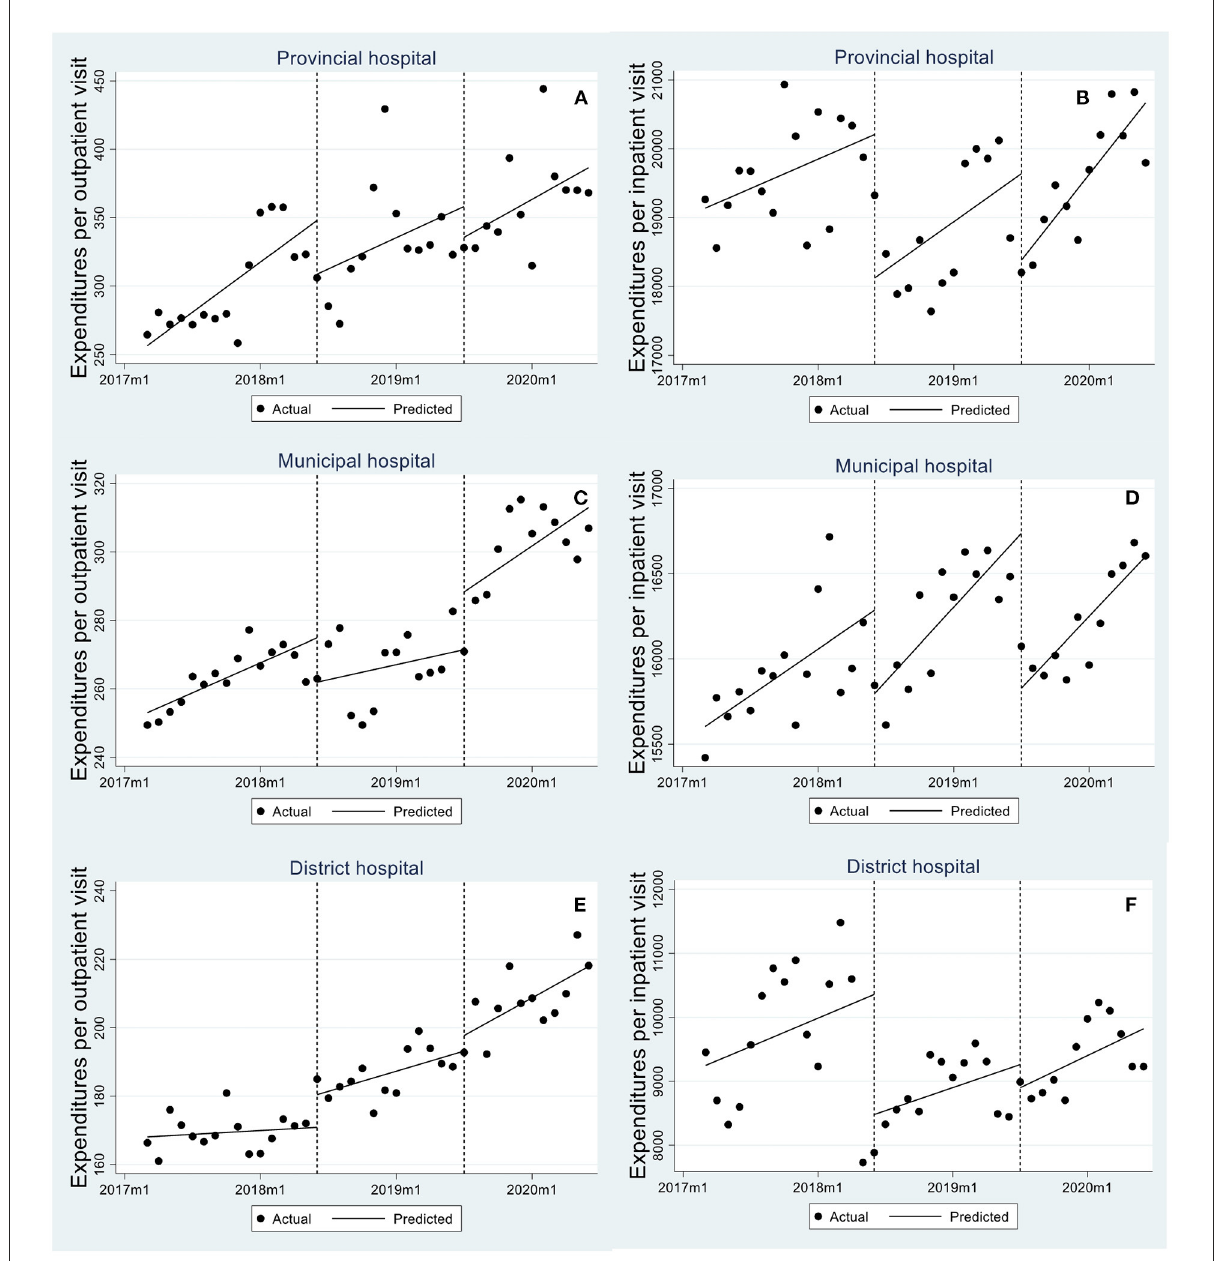
FIGURE2 Trend in monthly expenditures per outpatient visit/hospitalization in provincial, municipal, and district hospitals. (A,B) are expenditures per outpatient visit/hospitalization in provincial hospitals, (C,D) are expenditures per outpatient visit/hospitalization in municipal hospitals, and (E,F) are expenditures per outpatient visit/hospitalization in district